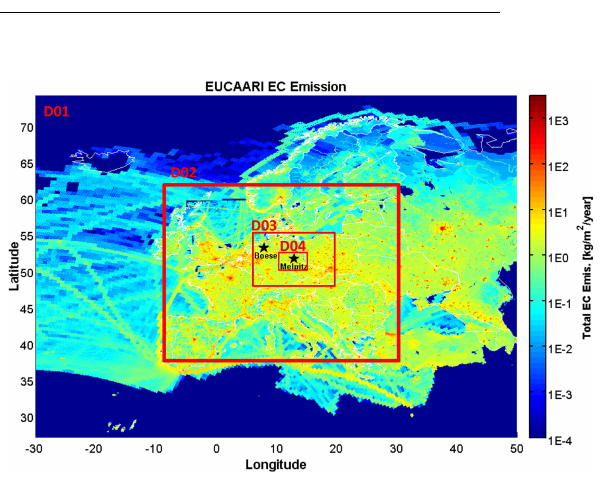
Figure 1. EUCARRI (resolution 7km) EC emission (kgm − 2 year − 1 ) . The 4 nested model domains (D01–D04) are indicated in the picture. Melpitz and Bösel (Boesel) are marked by black